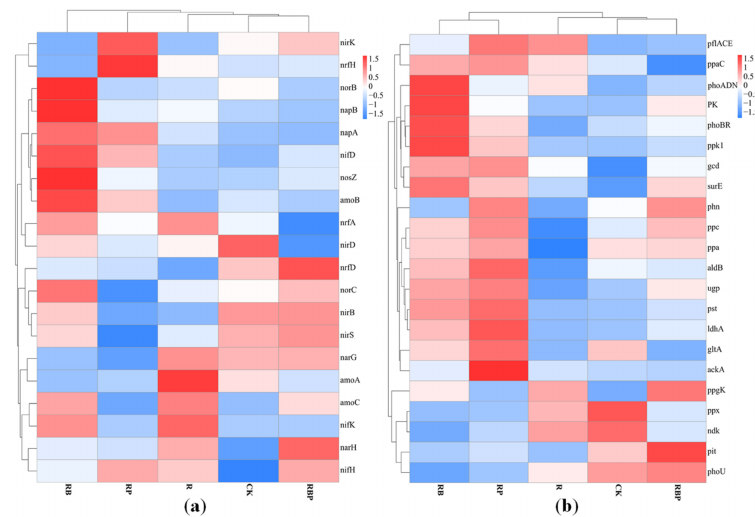
Figure 4. ( a ) Cluster analysis of genes related to N metabolism under different inoculation treatments. ( b ) Cluster analysis of genes related to P metabolism under different inoculation